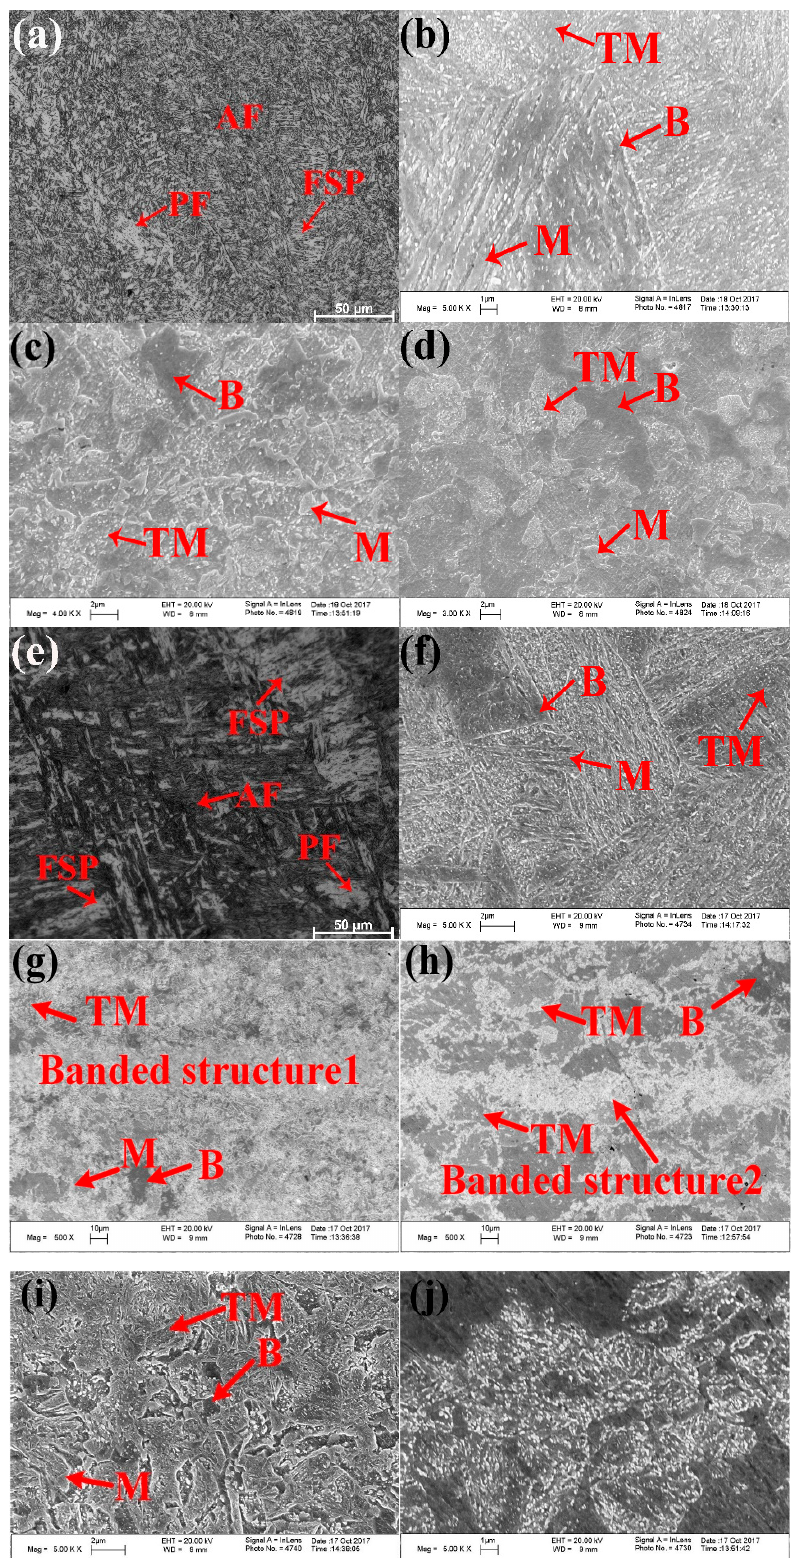
Figure 5. OM (optical microscopy) and SEM (scanning electron microscopy) micrographs showing the microstructures in different sub-zones of the welded joints: ( a ) FZ-UDW joint; ( b ) CGHAZ-UDW joint; ( c ) ICHAZ-UDW joint; ( d ) ICHAZ-UDW joint; ( e ) FZ-ULCW joint; ( f ) CGHAZ-ULCW joint; ( g ) ICHAZ-ULCW joint; ( h ) SCHAZ-ULCW joint; ( i ) Banded structure1; ( j ) Banded structure2.